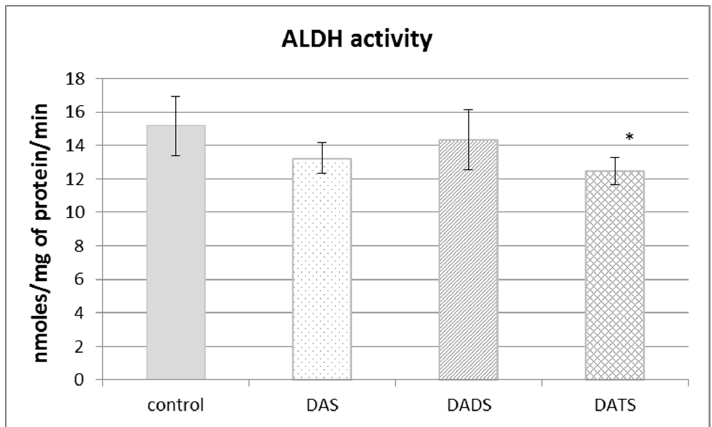
Figure 4. The effect of garlic-derived allyl sulfides (DAS, DADS and DATS) on the activity of aldehyde dehydrogenase (ALDH). Data represent the means of six animals in each group ± SD and are expressed as nmoles per 1 mg of protein per minute. Each assay was performed in triplicate. Statistically significant differences were determined by ANOVA followed by the Fisher test.